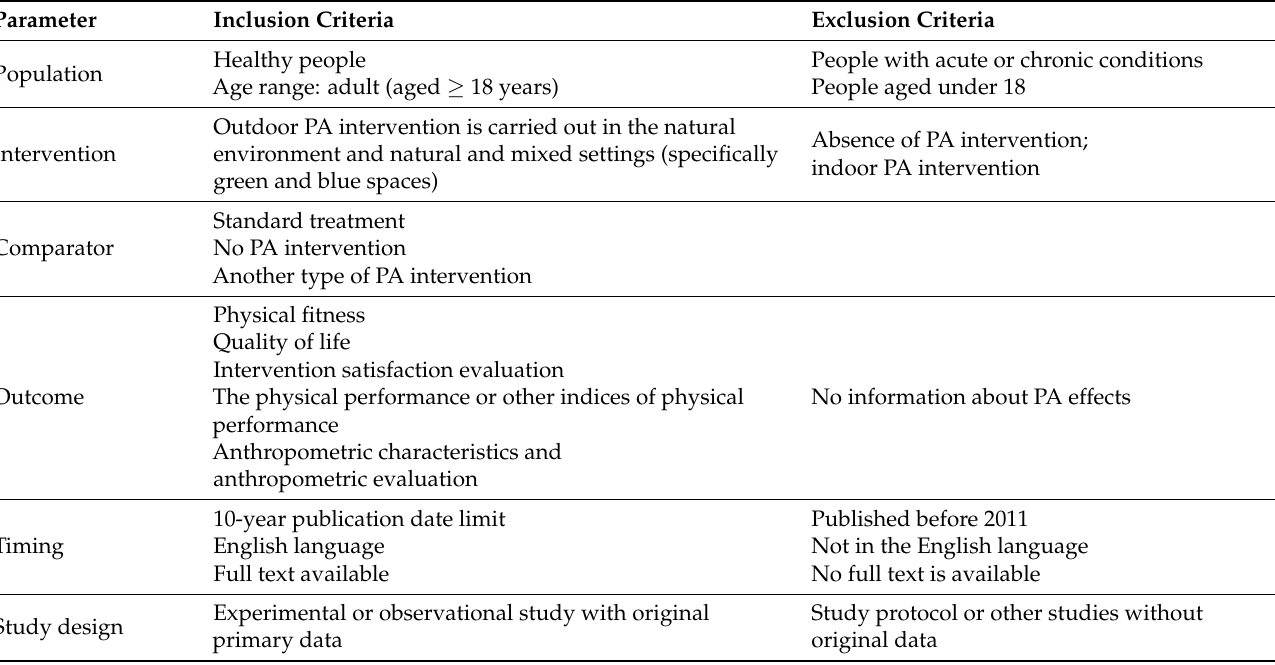
Table 1. PICOTS criteria for